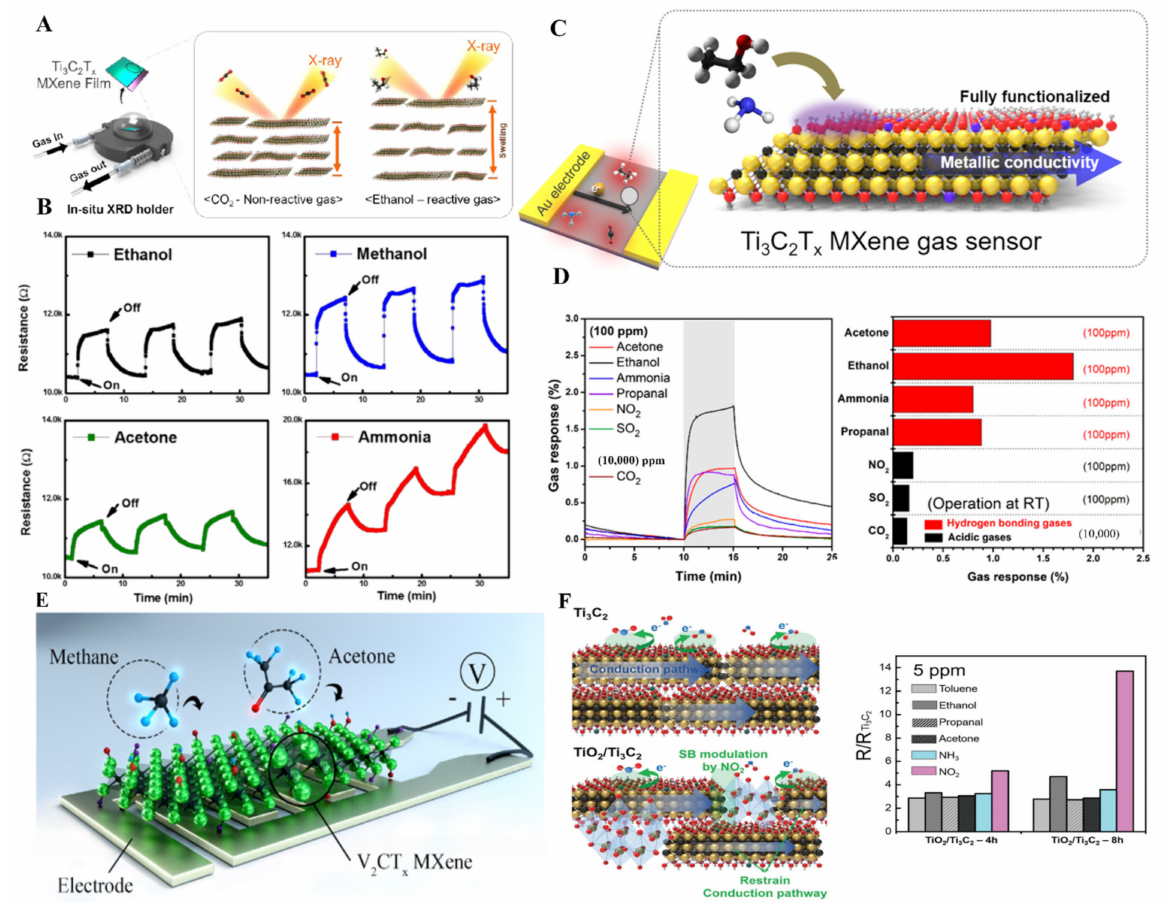
Figure 13. ( A ) Schematics of in situ XRD analysis of Ti 3 C 2 thin films sensing mechanism, (reproduced with permission [158]. Copyright 2019, American Chemical Society); ( B ) Gas-sensing results of